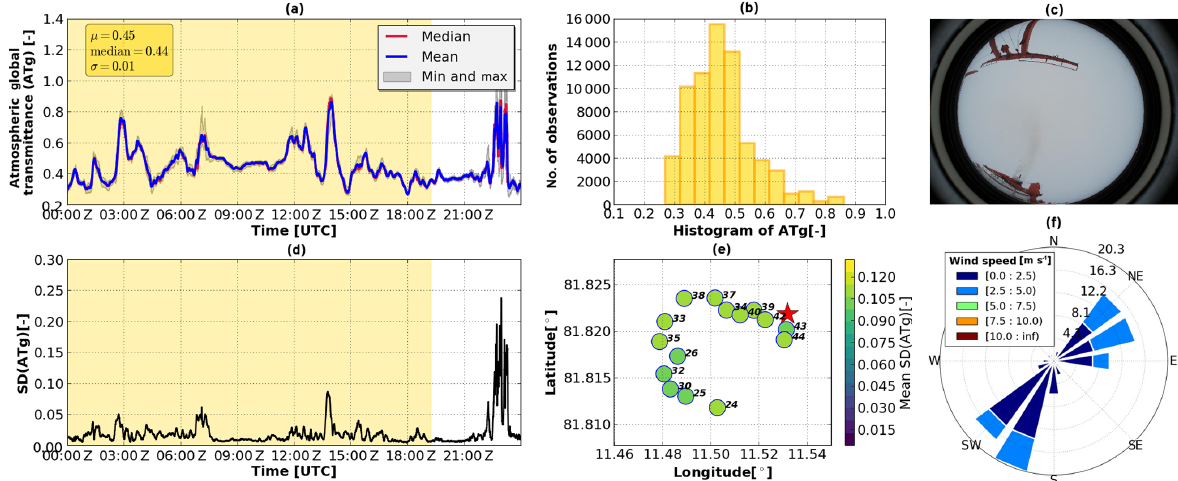
Figure 10. Overview of multilayer case: the same as Fig. 6 but for 13 June 2017, 00:00–19:15Z. All-sky camera photograph taken at 10:09:35Z.